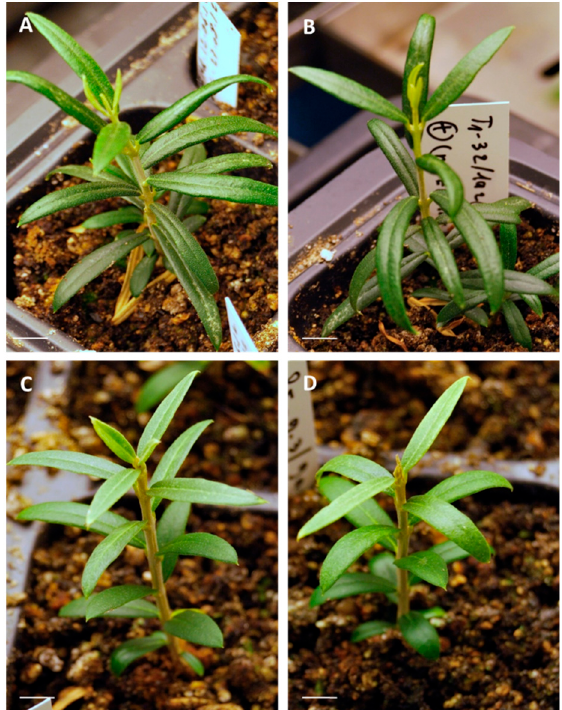
Figure 6. Acclimatization of olive plants developed from ( A , C ) control and ( B , D ) cryopreserved embryogenic cultures of the lines T1 ( A and B ) and P5 ( C and D ). Bar = 1 cm.